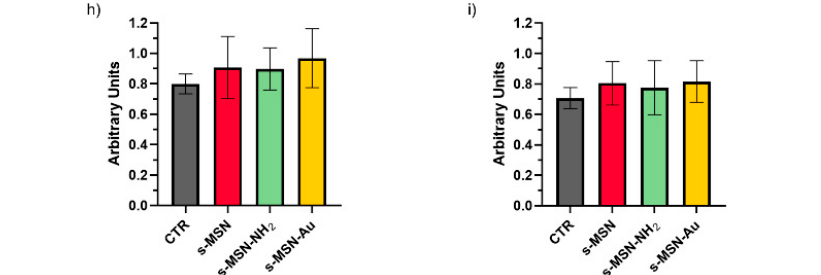
Figure 4. Long-term culture of human adult mesenchymal stem cells on silica star-shaped NPs and functionalized derivatives. ( a – c ) hBM-MSCs; ( d – f ) hASCs. ( a , d ) Proliferation rate. ( b , e ) Representative Western blotting bands of SOD1 expression in hBM-MSCs and hASCs at D7, and ( c , f ) densitometric analysis of Western blotting performed at each time point of culture. The results of each bar are the mean ± SEM of three independent experiments. p < 0.05 was considered significant. ( g ) Representative fluorescence images of Acridine Orange staining. Scale bar = 20 µm. ( h , i ) Quantification of the Acridine Orange staining (see method section for details). ( h ) hBM-MSCs; ( i ) hASCs. The results are reported as mean ± SEM of three independent experiments. p < 0.05 was considered significant.